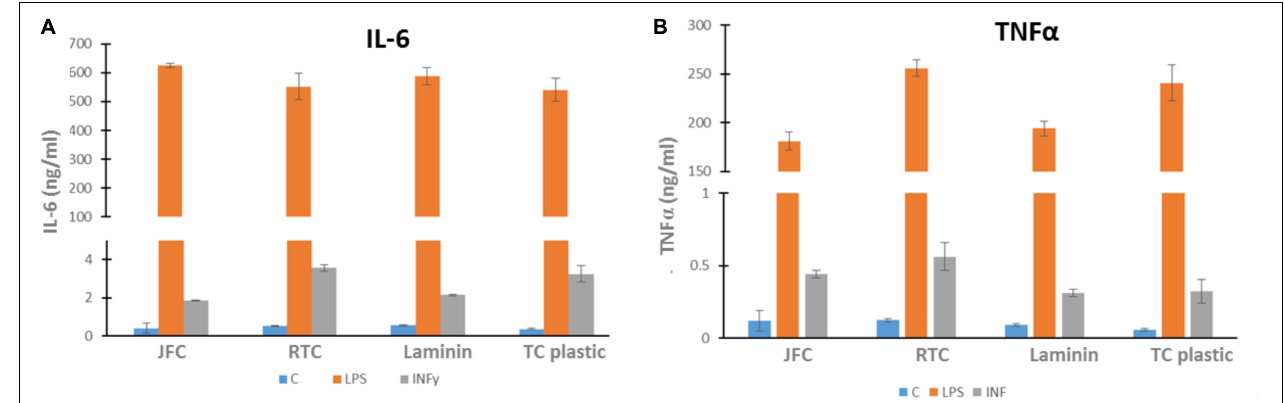
FIGURE 8 | Cytokine output by iMGL at baseline and following 24 h stimulation. iMGL were cultured on Jellagen R (cid:13) (JC), rat tail collagen I (RTC), laminin or TC plastic for 48 h prior to stimulation with LPS (100 ng/mL) or INFY (10 ng/mL) for a further 24 h. Cell supernatants were collected and ELISA performed. Data represent mean ± SEM of 6 technical